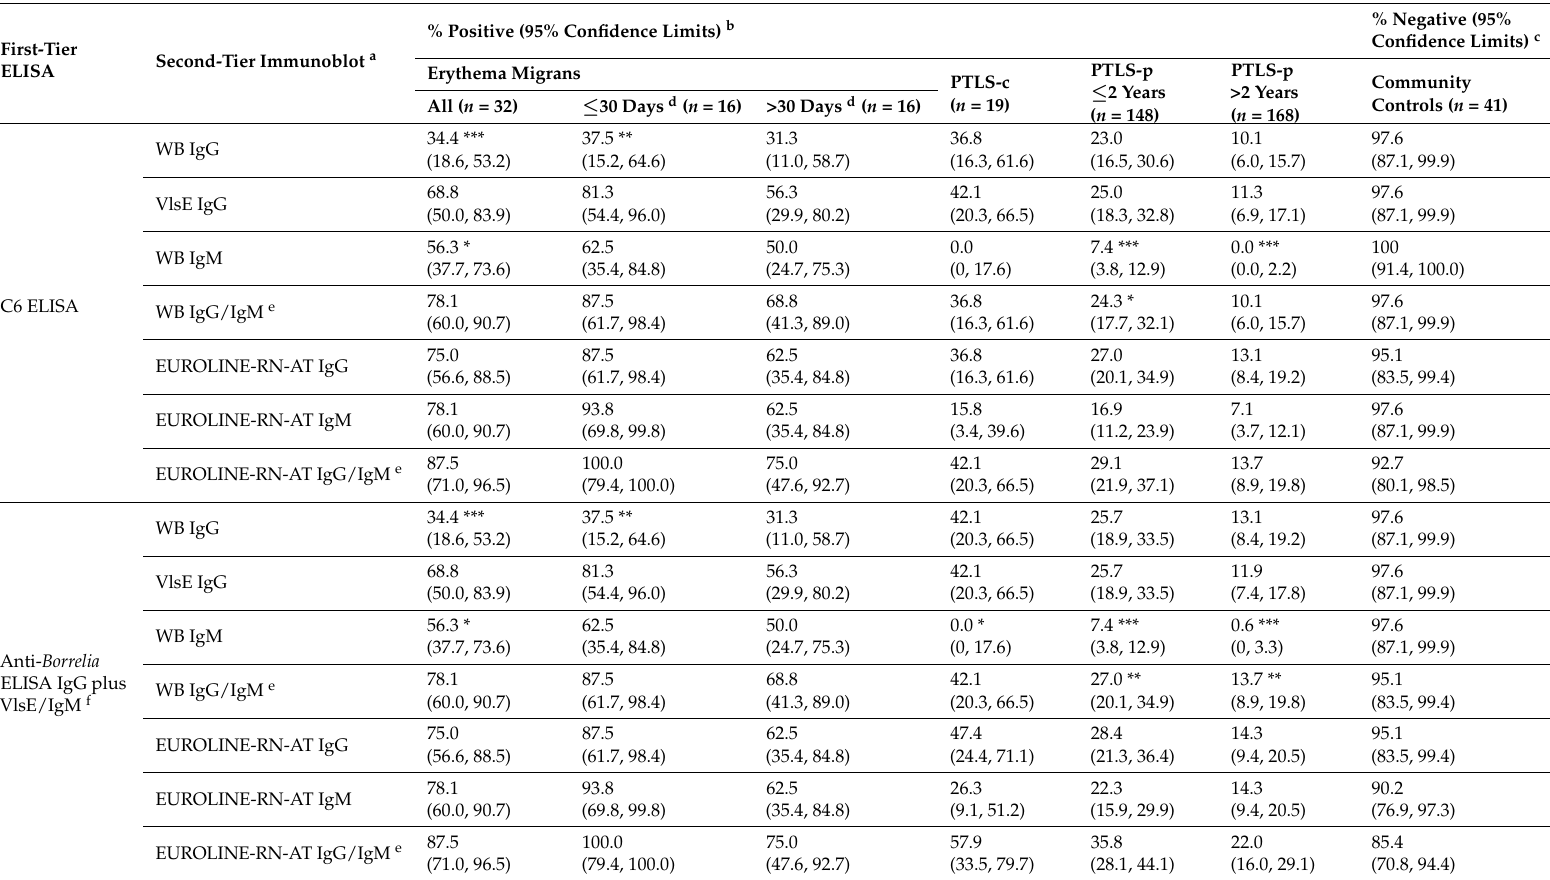
Table 5. Prevalence of anti- Borrelia antibodies by two-tiered testing (ELISA-immunoblot) among patients with erythema migrans or post-treatment Lyme symptoms